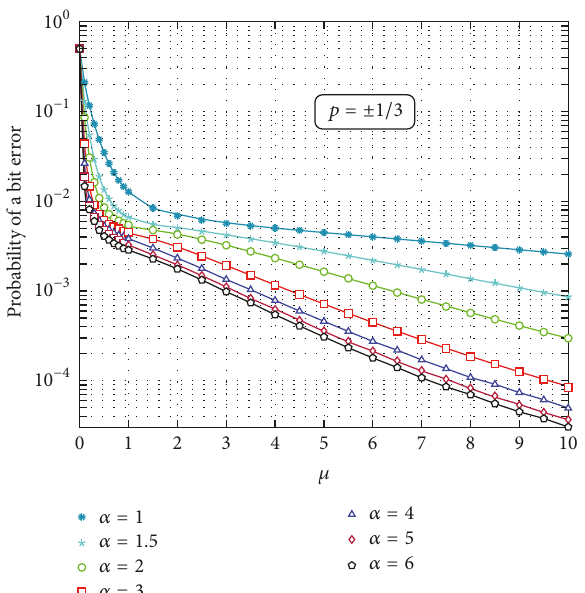
Figure 6: Average BER against the fading parameter 𝜇 under 𝛼 - 𝜇 fading channel with SNR = 20 dB, 𝐿 = 3 , and 𝑝 = 1/3 .